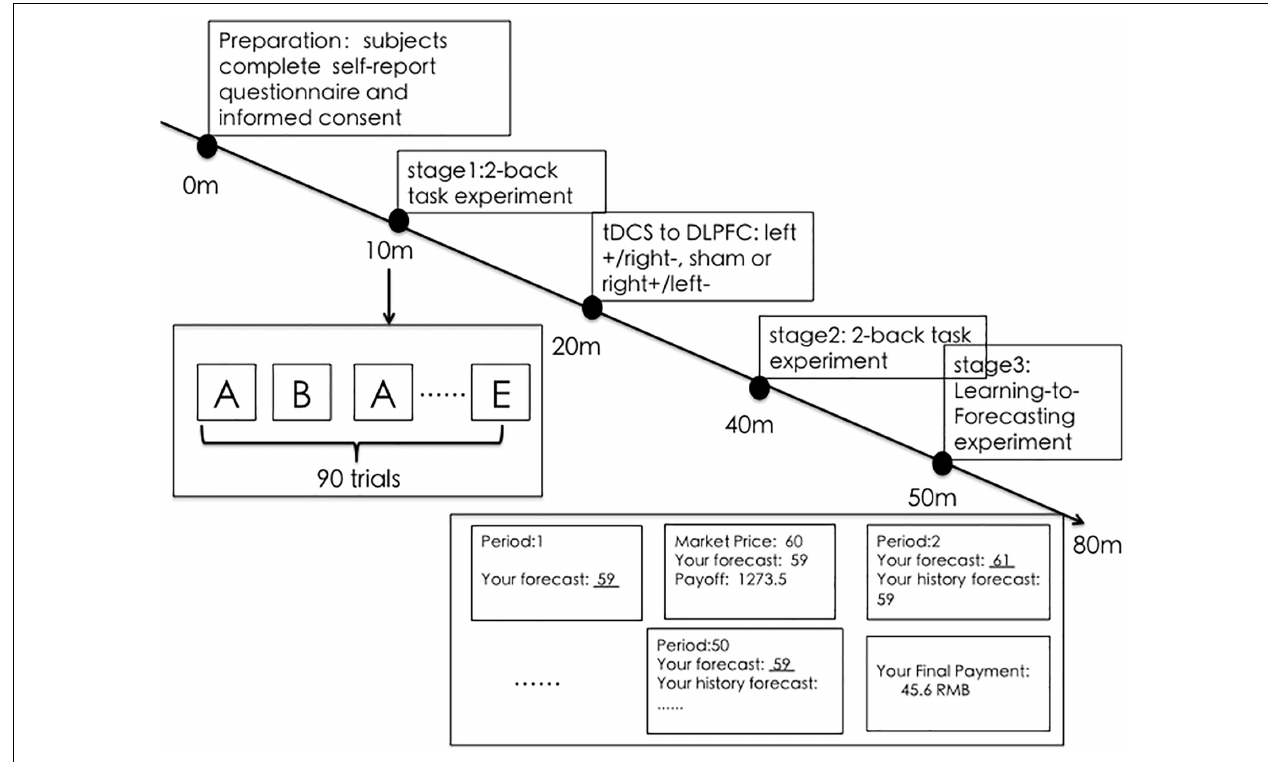
FIGURE 1 | The procedure and schedule of the whole experiment. The subjects were first asked to perform a 2-back task experiment and then randomly separated into different tDCS groups: left+/right–, sham, or right+/left–. After receiving tDCS to the DLPFC, they performed the 2-back task again. Finally, they were asked to perform a 50-period learning-to-forecast